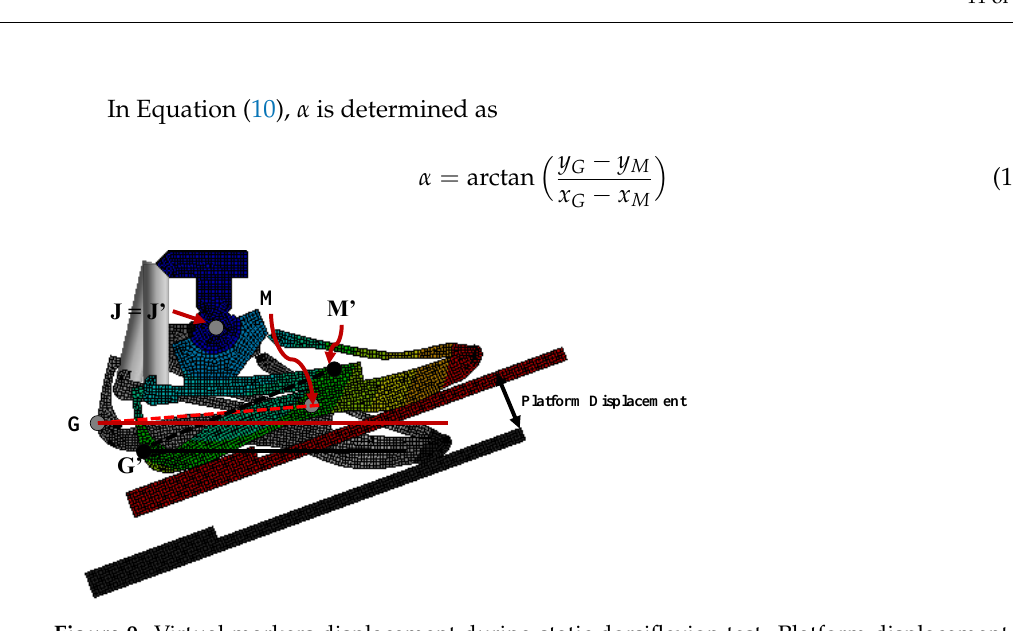
Figure 9. Virtual markers displacement during static dorsiflexion test. Platform displacement at 0 (black and white image) mm vs. platform displacement at 50 mm.